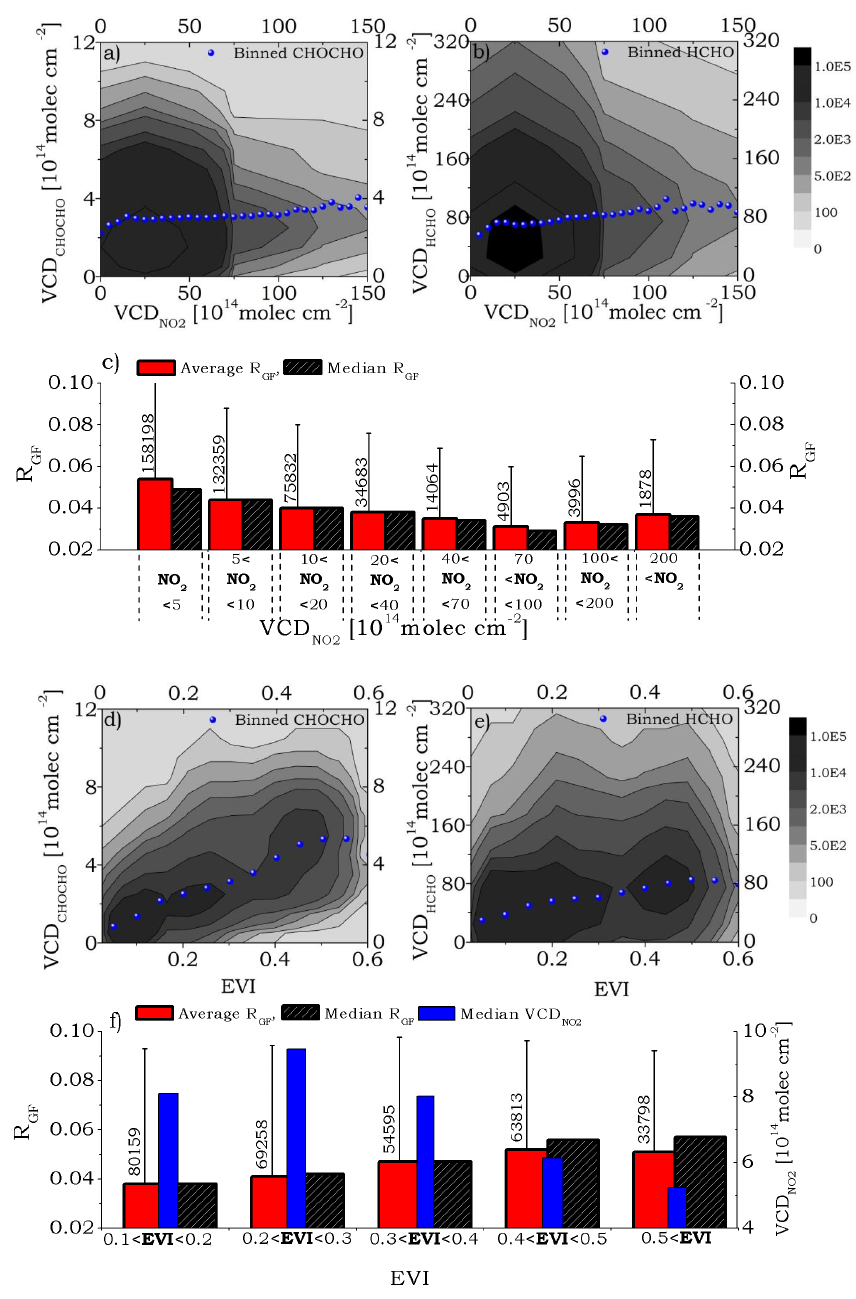
Fig. 6. 2-D frequency analysis of VCD CHO . CHO and VCD NO (panel a ), VCD HCHO and VCD NO (panel b ), VCD CHO . CHO and EVI (panel 2 2 d ), VCD HCHO and EVI (panel e ). Blue dots are the binned OVOCs per 5 × 10 14 moleccm − 2 of NO 2 and 0.05 units of EVI, respectively. Panels ( c ) and ( f ) present the average (red bars) and median (black bars) R GF ratios as a function of various NO 2 and EVI levels, respectively. For a given group of NO 2 column amounts covering non polluted to polluted conditions and of EVI values covering bare land to vegetated areas, the ratio of the column amounts of glyoxal to formaldehyde is computed. The blue bars of panel (f) represent the NO 2 levels computed for each of the EVI categories. The numbers close to the side of the standard deviations coupled to the average R GF denote the number of pairs used in the analysis of the